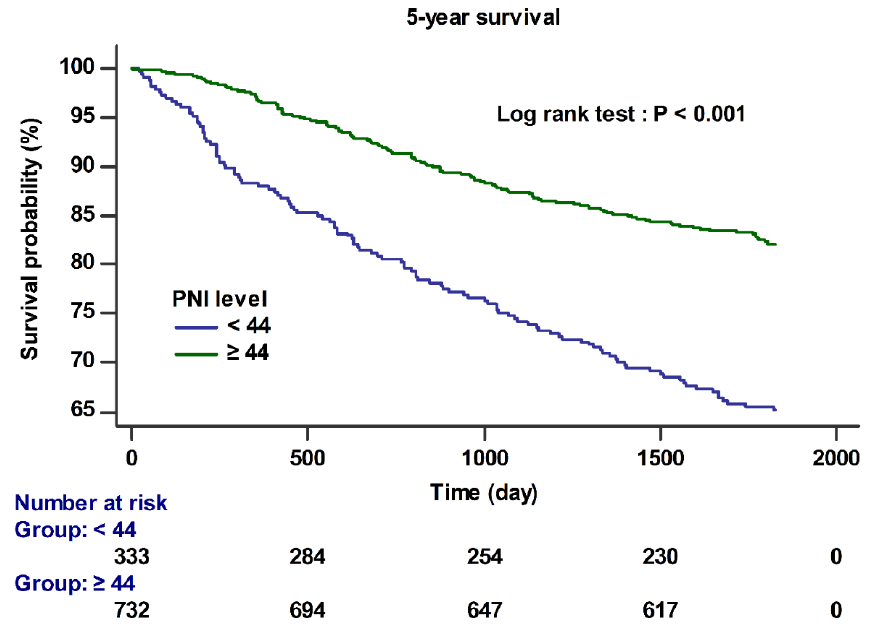
Figure 2. Kaplan–Meier survival curves for 5-year survival according to the preoperative PNI cut off value <44 (log-rank test; p < 0.001).